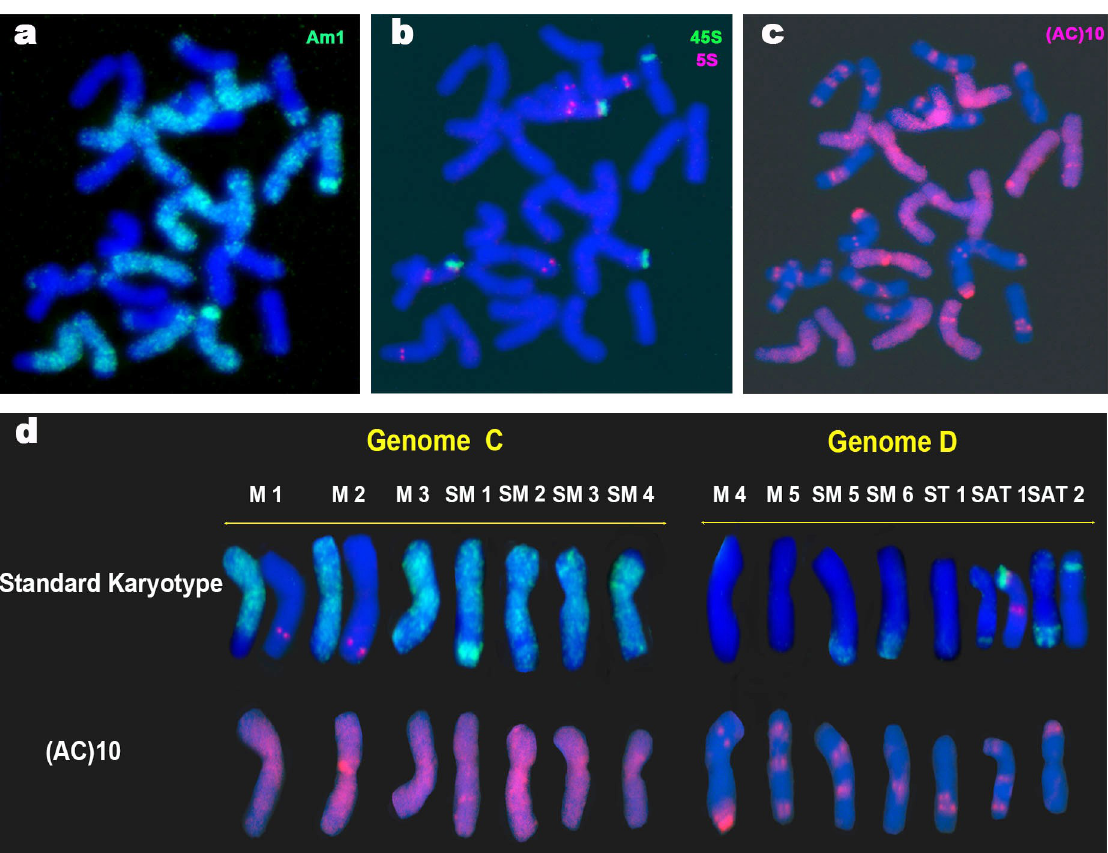
Fig 1. FISH of a mitotic metaphase cell of A . insularis showing the distribution of repeated sequences Am1, 45S, 5S and AC. (a) Am1 (green). (b) 45S (green) and 5S (red). (c) SSR AC (red). (d) A . insularis karyotype showing a single chromosome of each homologous pair. The standard karyotype is based on the distribution patterns of Am1 (green), 45S (green) and 5S (red). Chromosome nomenclature is based on that of Jellen and Ladizinsky [9].